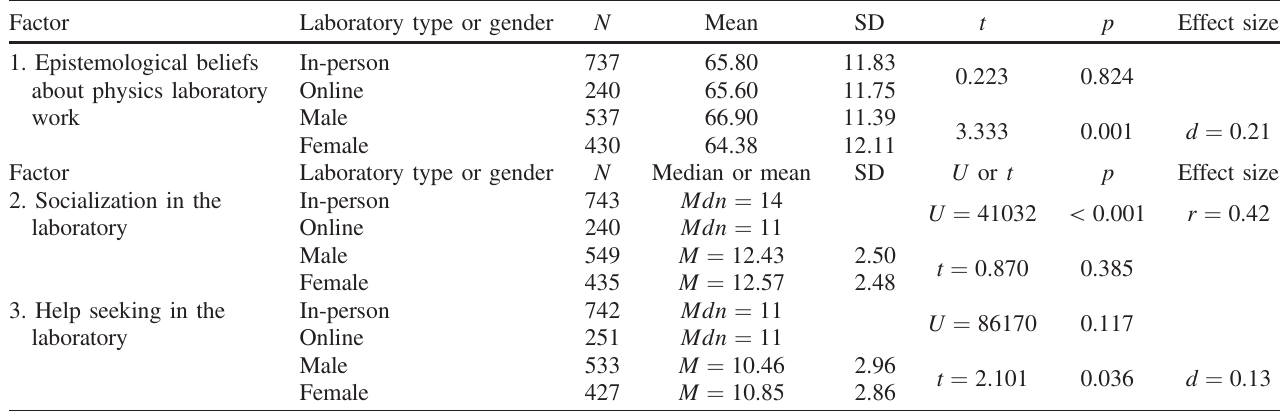
TABLE III. Statistical tests of subconstructs by laboratory course type and gender.